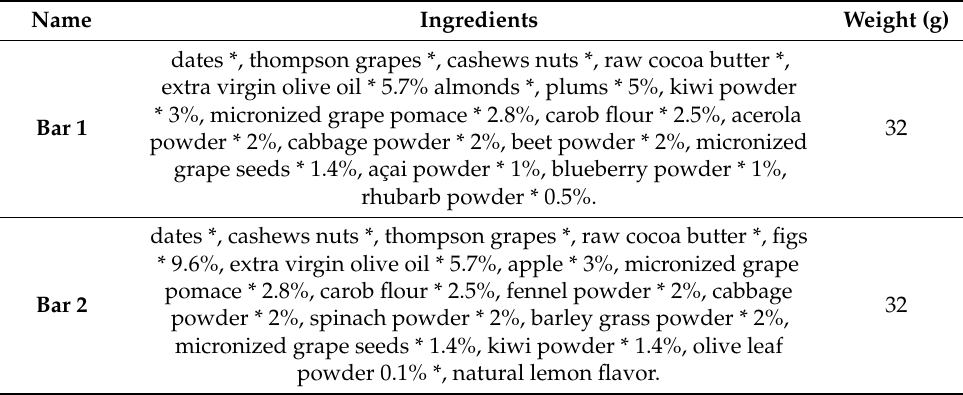
Table 1. Composition of functional bars based on organic fruit and vegetables. Legend: * Organic.